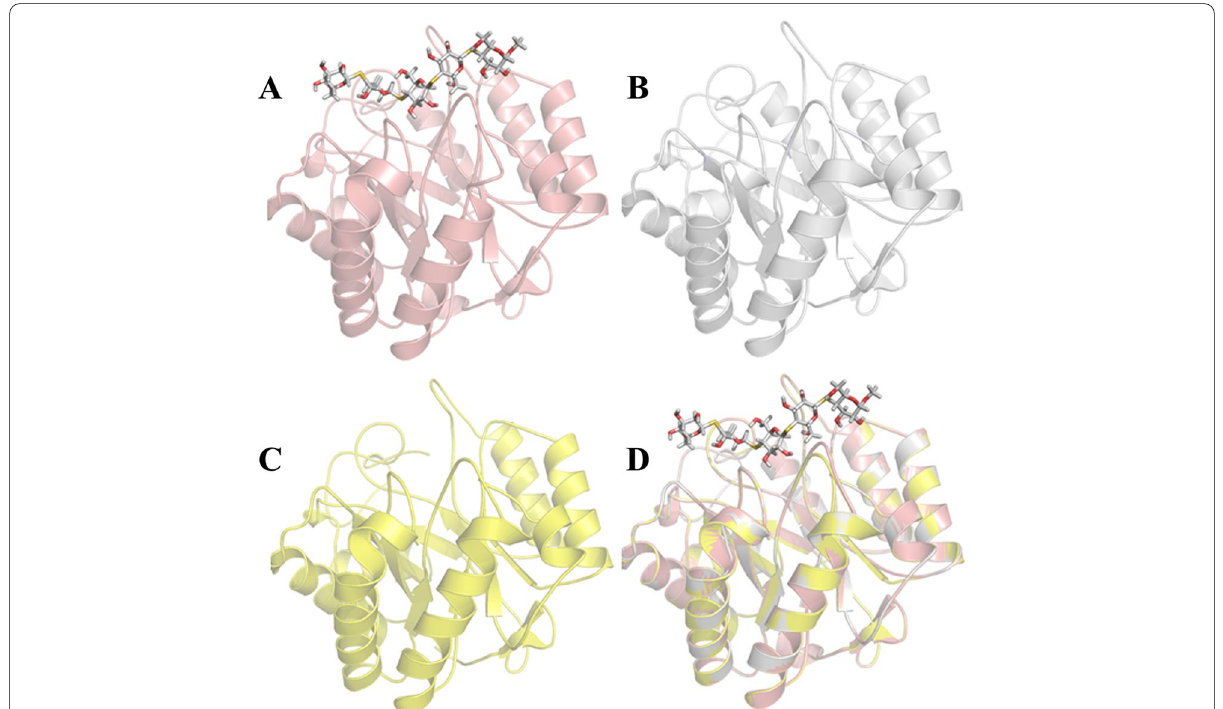
Fig. 2 Ribbon diagrams of Ba Cel5A crystal structure (PDB ID: 1H5V) A . Bl Cel5H homology model B , Pp Cel5A homology model C , and superimposition of template and model structures D . The cellulose mimic (4,4 II ,4 III ,4 IV -tetrathio-α-cellopentoside) which is in bound form with Ba Cel5A was represented with